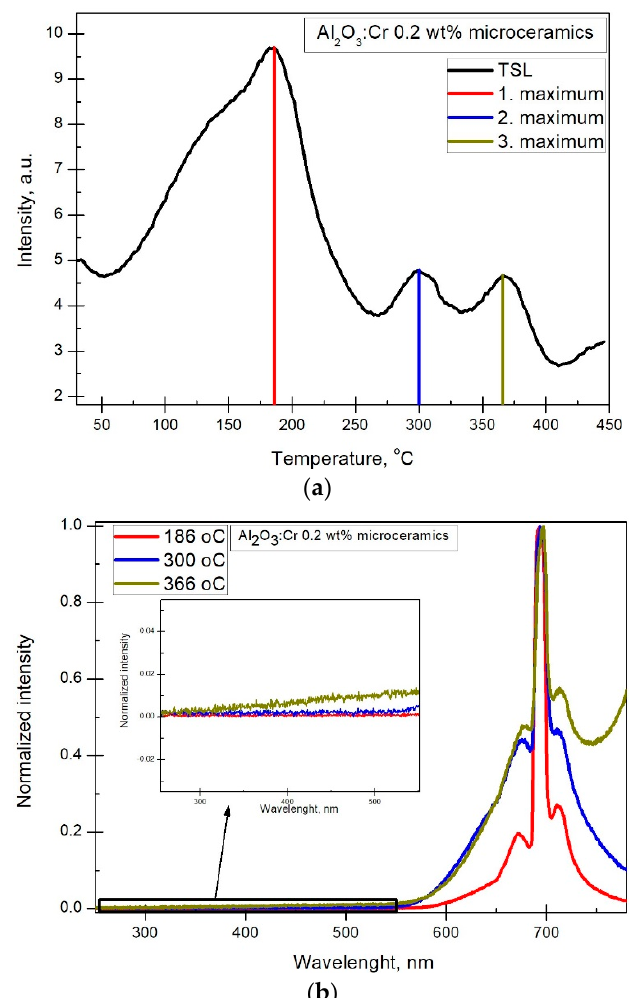
Figure 6. ( a ) Single TL measurement of Al 2 O 3 : Cr with 0.2 wt% Cr 2 O 3 . ( b ) Al 2 O 3 : Cr with 0.2 wt% Cr 2 O 3 luminescence spectra of the 3 corresponding peaks. Insert shows that no meaningful signal was registered from 250 to 550 nm.